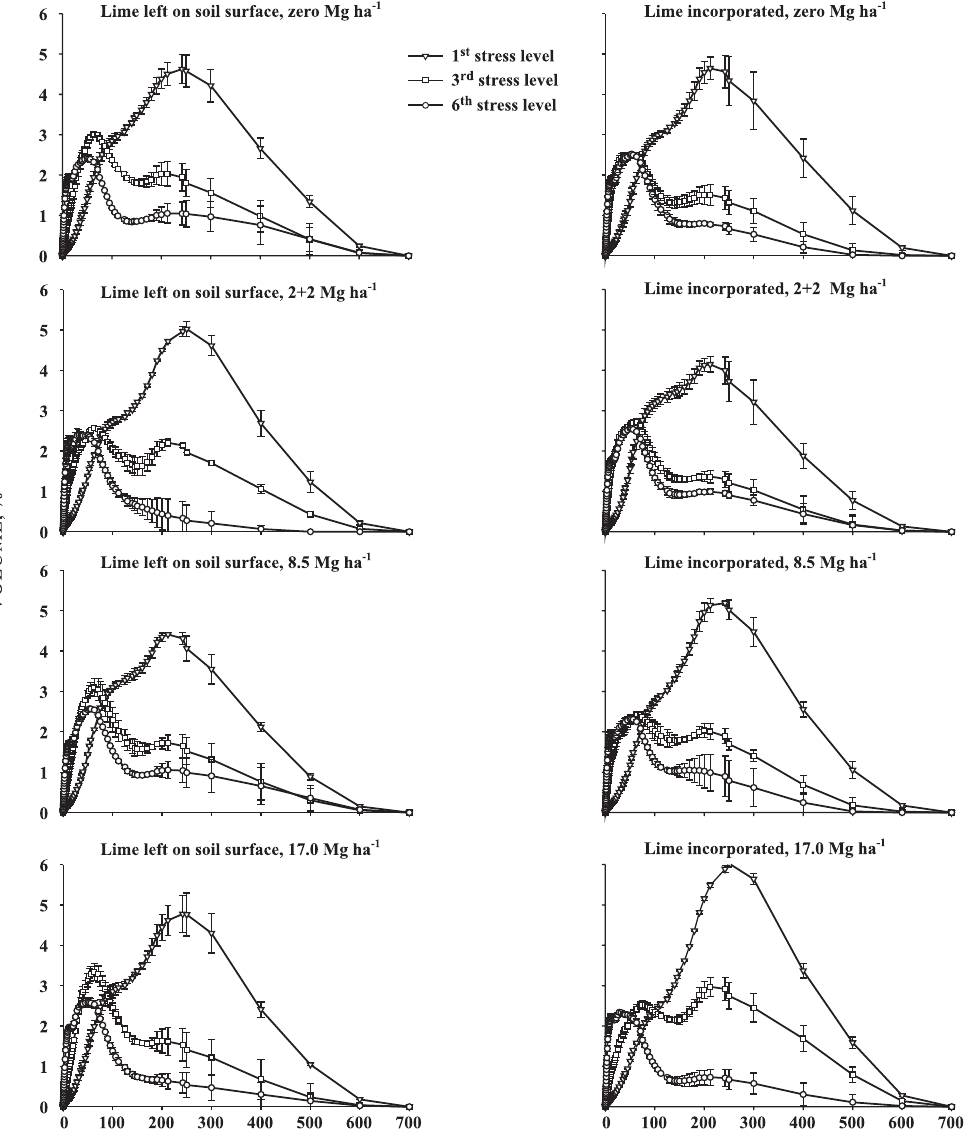
Figure 1. Laser diffraction (DL) diagrams representing aggregates between 1 and 2 mm under stress levels: 1st, immediately after placing the aggregates inside the DL-cell containing deonized water; 3rd, after three minutes of agitation in the presence of 5 mL of Calgon®, and 6th, after three minutes of agitation under ultrasound at 35 W. The samples are from an Acrisol, at 0–0.05 m of depth, under liming in different doses and forms of application (lime left on soil surface and incorporated). The results are expressed in percent of the aggregate size classes by volume. The vertical bars indicate the mean standard error (n =